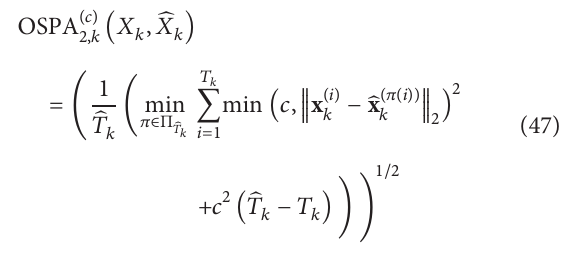
Figure 3: The 500 MC run averages of OSPA against